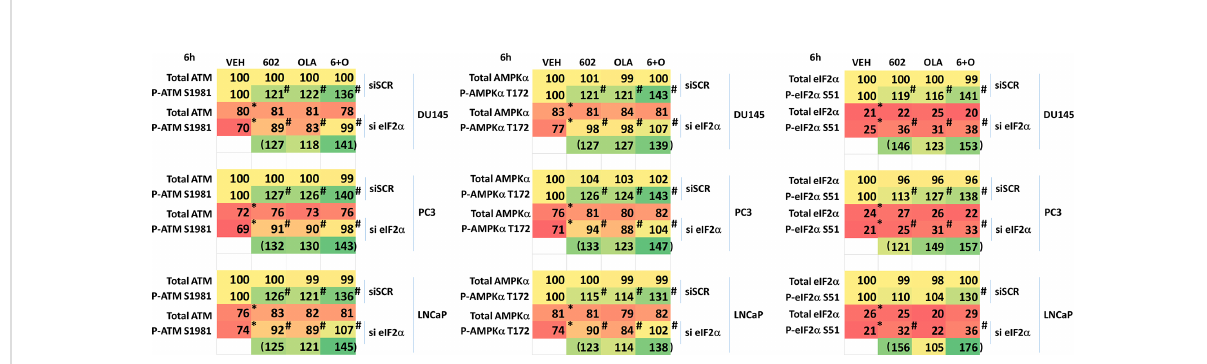
FIGURE 8 Activation of ATM and the AMPK by GZ17-6.02 alone or in combination with olaparib requires ER stress signaling. Cells were transfected with a scrambled siRNA or with an siRNA to knock down the expression of eIF2 a . After 24h, cells were treated with vehicle control, GZ17-6.02 (2 m M), olaparib (50 nM) or the drugs in combination for 6h. Cells were fi xed in situ, permeabilized, stained with the indicated validated primary antibodies and imaged with secondary antibodies carrying red- and green- fl uorescent tags. The staining intensity of at least 100 cells per well/ condition is determined in three separate studies. The data are the normalized amount of fl uorescence set at 100% comparing intensity values for vehicle control (n = 3 +/-SD). #p < 0.05 greater than vehicle control; *p < 0.05 less than vehicle